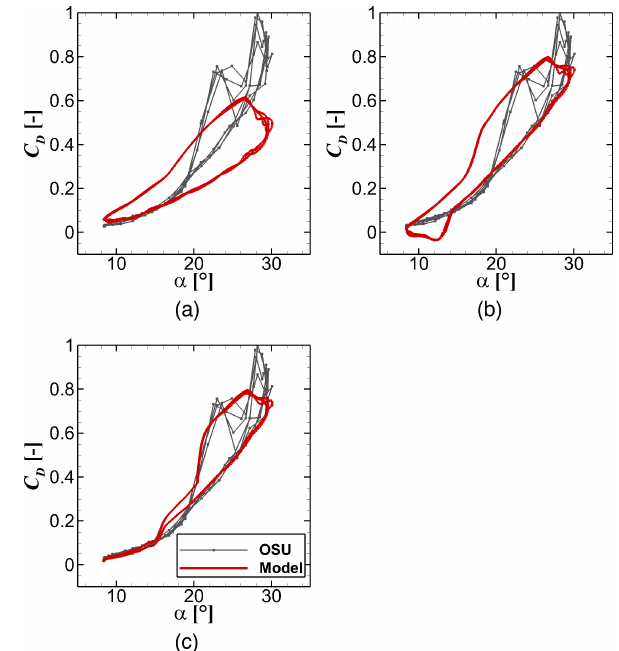
Figure 4. Drag reconstruction in comparison with the experimental data for the S801 airfoil (Ramsay et al., 1996) applying (a) Eq. (19), (b) Eq. (62), and (c) Eqs. (62) and (64).